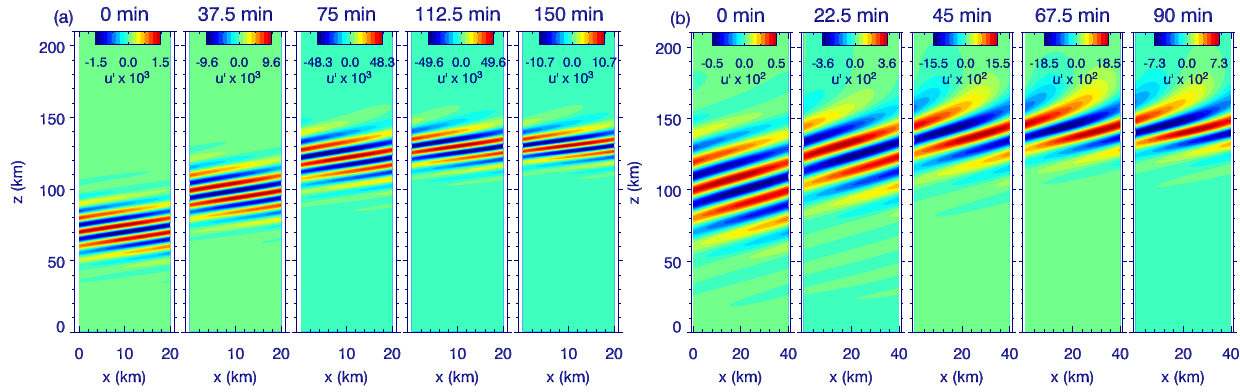
Fig. 10. (a) Horizontal wind perturbations for GW with initial λ z = 10km propagating in the isothermal atmosphere with Pr = 1 at various times (labeled). (b) Same as (a) , but for GW with initial λ z = 20km. The times are different than in (a) .